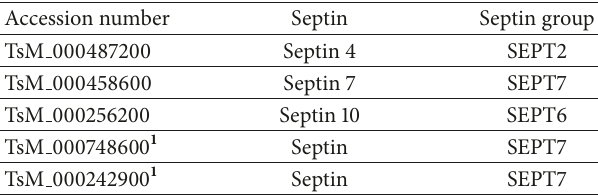
Table 1: Sequences of septins in Taenia